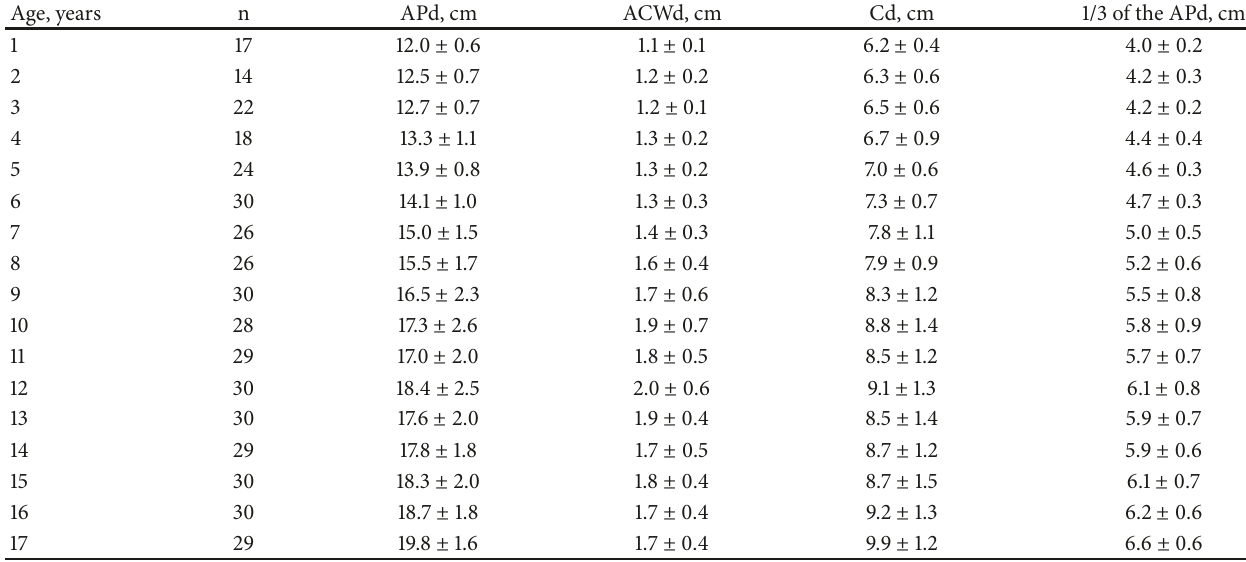
Table 2: APd, ACWd, Cd, and 1/3 of the AP diameter by age group among patients aged 1–18 years.